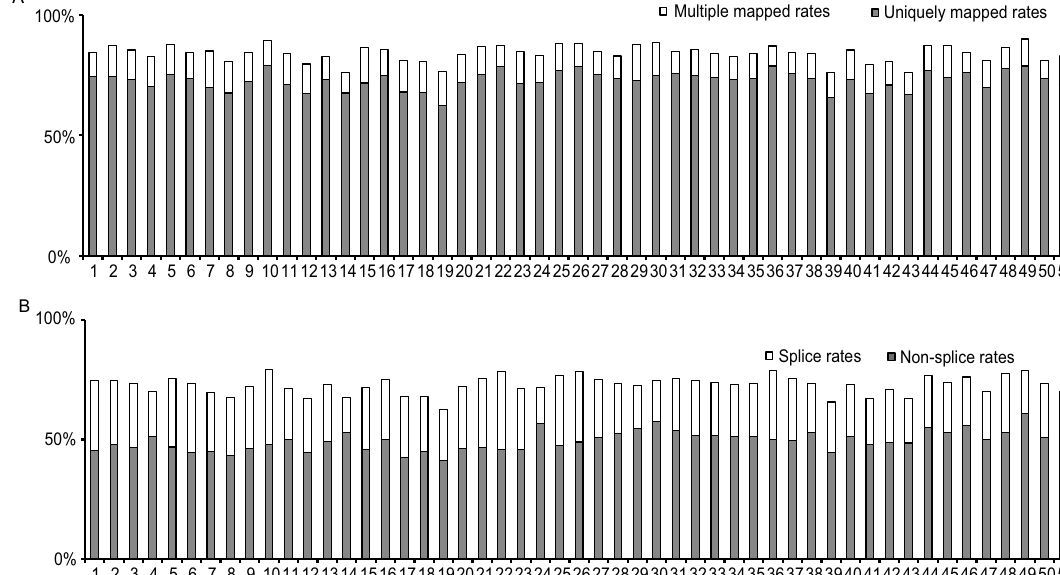
Figure 1. The mapping rates of the clean data in 26 indica and 25 japonica plants. ( A ) The mapping rates of the clean data. The white block represents the rate of multi-mapped reads, and the grey block indicates the rate of uniquely mapped reads. ( B ) The splice rate in 51 rice plants. The white block represents the splice rate, whereas the grey block indicates the non-splice rate. The numbers associated with the x-axis correspond to the sample name (see Table S1 for sample information). This figure was created using Microsoft Excel 2013 and Adobe Illustrator